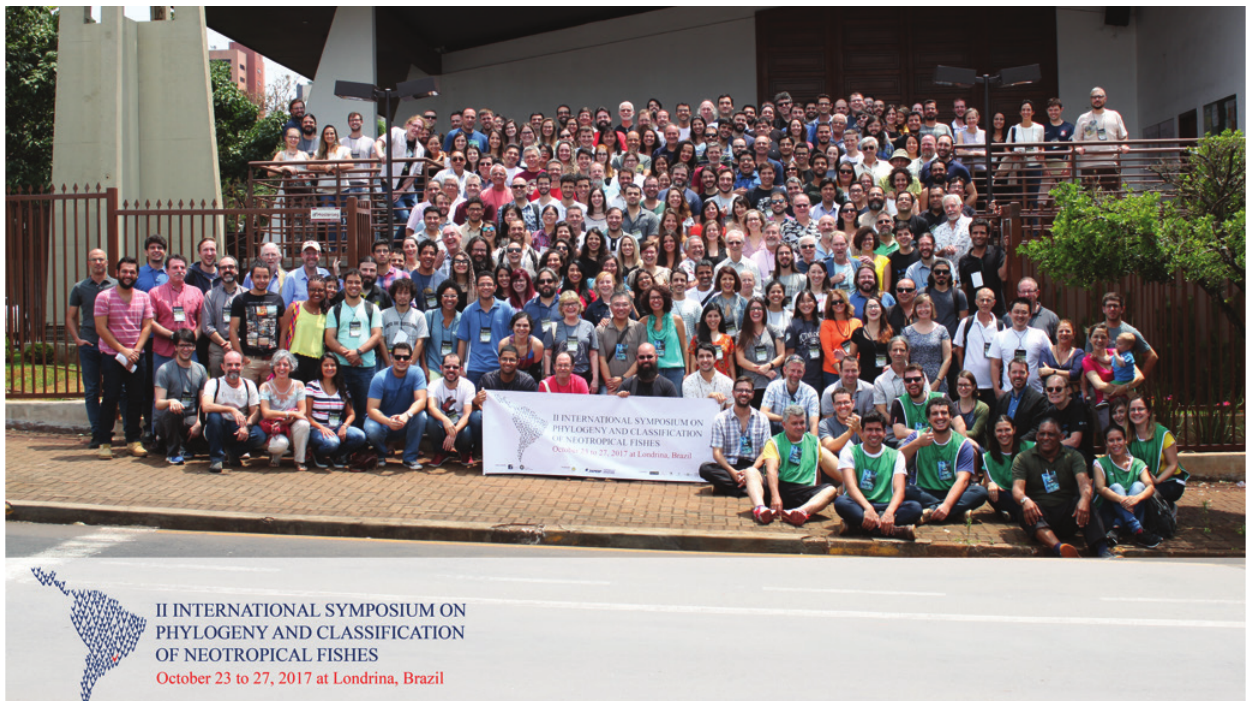
Fig. 2. Official group photograph of the II International Symposium on Phylogeny and Classification of Neotropical Fishes, taken in Londrina, Paraná state, Brazil, on October 25 th , 2017, which included 238 of the 264 restriged